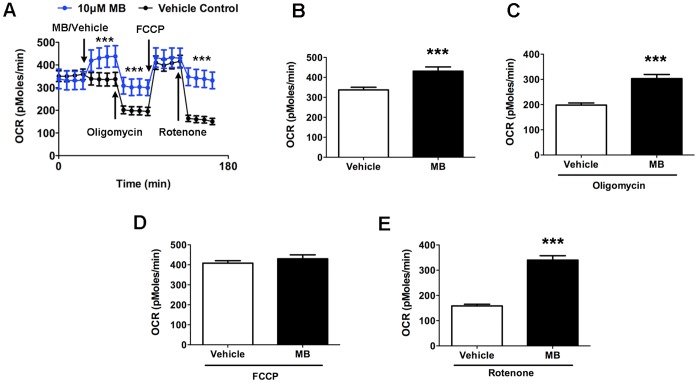
MB increases OCR in HT-22 cells.(A) We monitored cellular OCR with sequential administration of MB/vehicle, oligomycin, FCCP, and rotenone. Quantitative analysis of OCR shows that MB increases OCR under (B) normal, (C) ATP synthase inhibition (oligomycin), (D) FCCP, and (E) complex I inhibition (rotenone). Data are mean ± SD; ***, p<0.001.